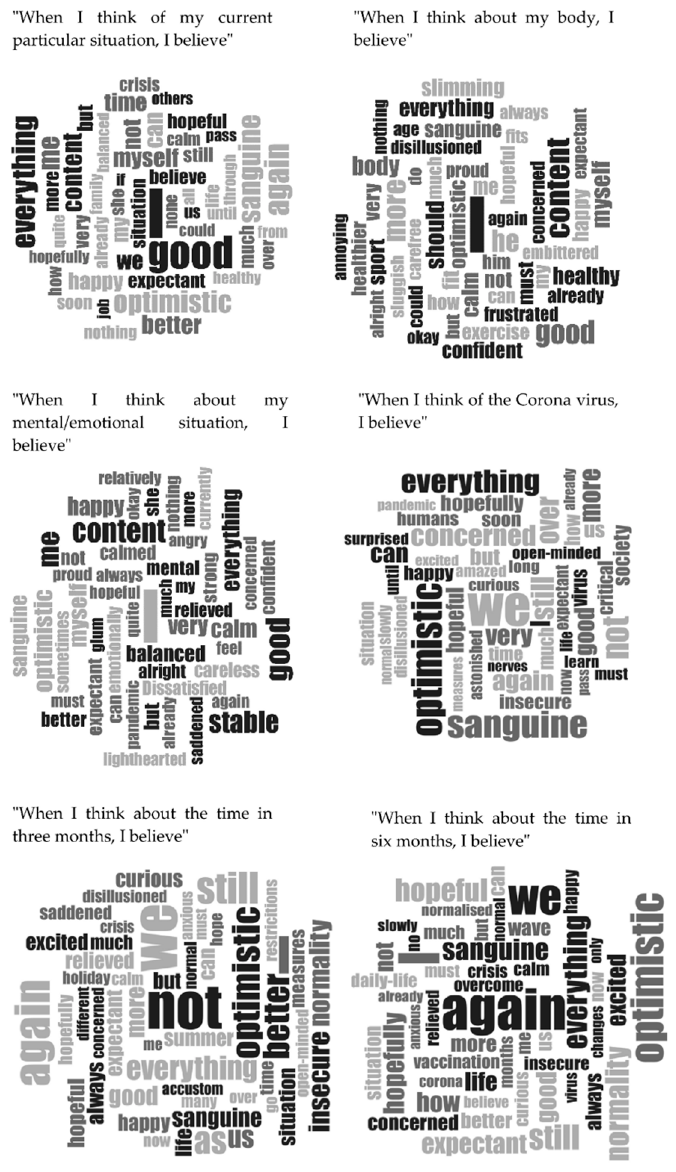
Figure 1. Most frequent words for the items of the Believing Questionnaire.